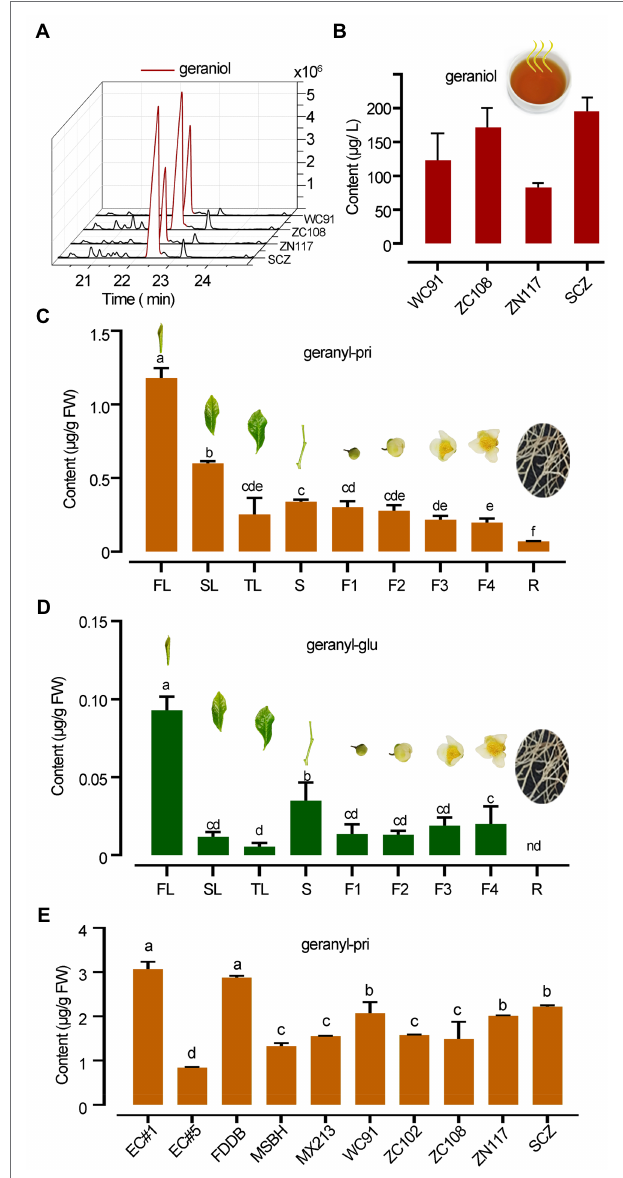
FIGURE 2 | Distinct abundance difference in geraniol and its glycosides in tea. (A,B) GC chromatography and quantitative column presentation of geraniol SPME collected in tea infusion headspace of different teas. (C,D) The abundances of geranyl primeveroside (geranyl-pri) and geranyl glucoside (geranyl-glu) in different organs of “SCZ” tea plants. FL, SL, and TL, first, second and third leaves; S, tender shoot stem; F1–F4, flowers at different developmental stages; R, tender roots. (E) Quantification of geranyl primeveroside in different tea cultivars. Columns with different letters had significant differences in the abundances of the same compound ( p < 0.05) using the statistical method described in text. EC1, “Echa NO.1”; EC5, Qualitative analysis identified geraniol from the infusion of black teas, geranyl glucoside and primeveroside in freshly excised tea